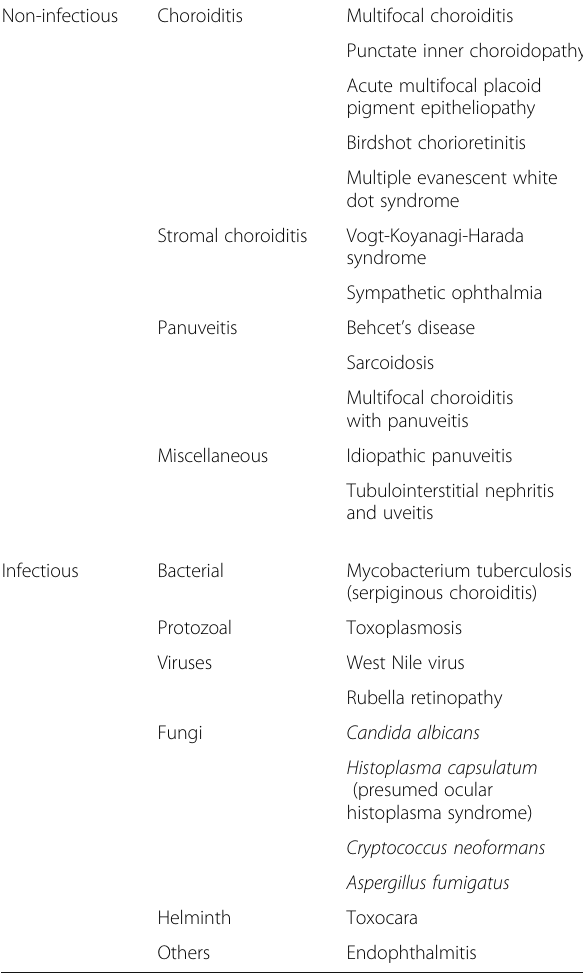
Table 1 Various uveitic entities associated with inflammatory choroidal neovascular membranes